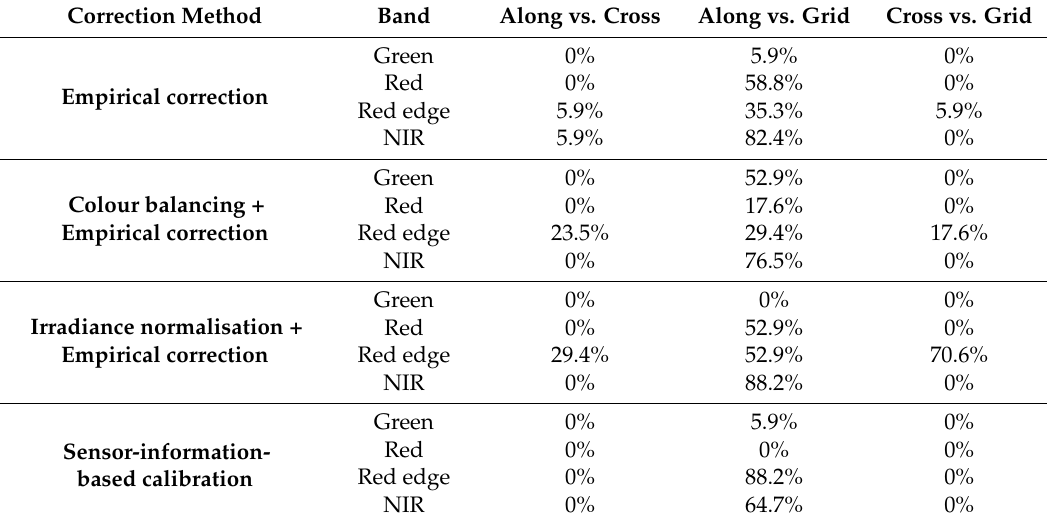
Table A3. Reflectance consistency percentages of tree canopies between different flight patterns in dataset 3.